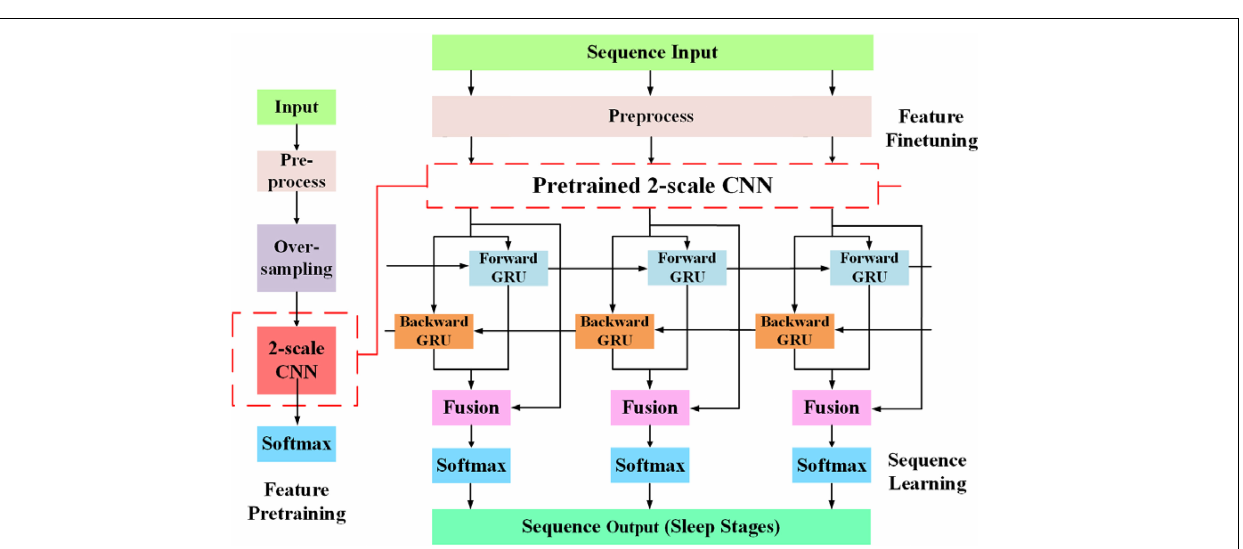
FIGURE 5 | The entire training process, which can consider both oversampling and sequence information